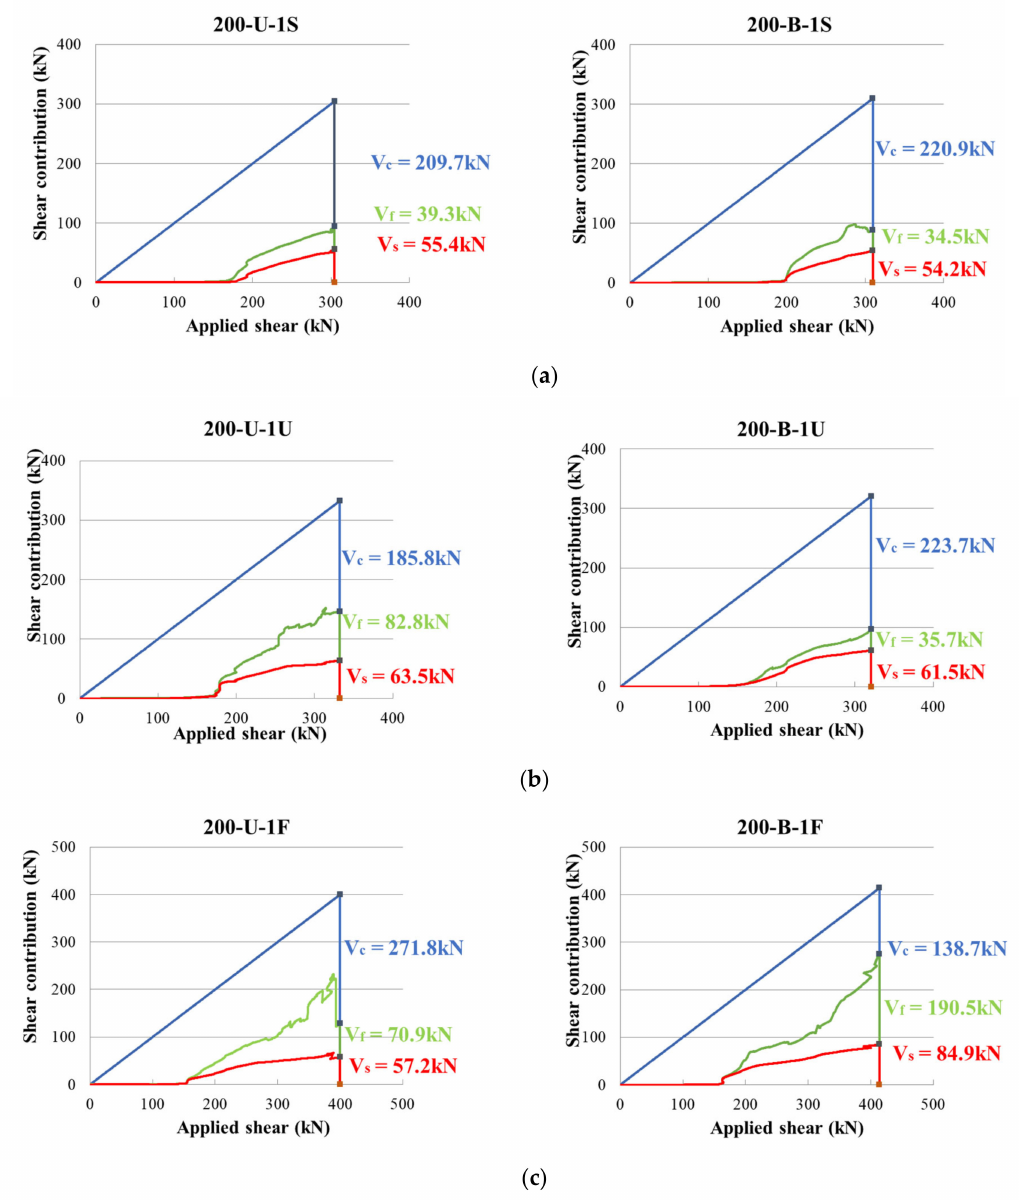
Figure 9. Measured shear contribution of concrete, stirrups and CFRP strips in second series of specimens: ( a ) 200-U-1S vs. 200-B-1S; ( b ) 200-U-1U vs. 200-B-1U; ( c ) 200-U-1F vs.